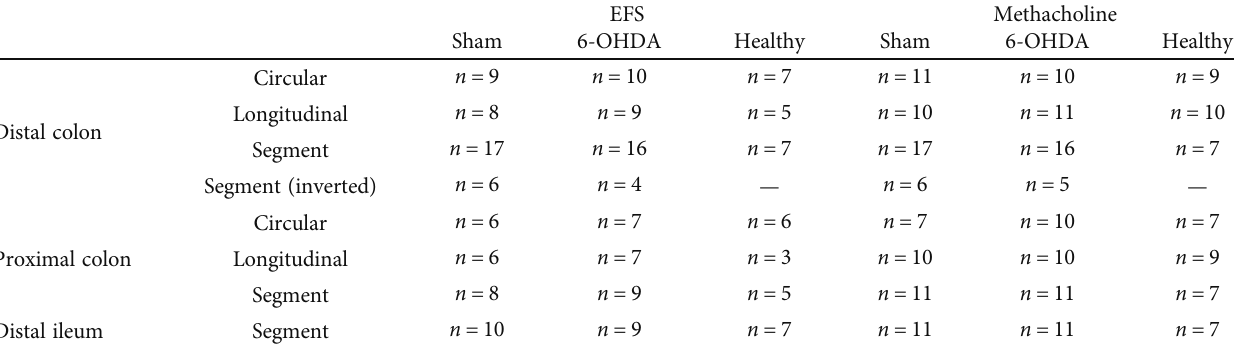
Table 1: Number of included tissue samples for electrical fi eld stimulation (EFS) and methacholine in the Sham and 6-OHDA-lesioned and Healthy